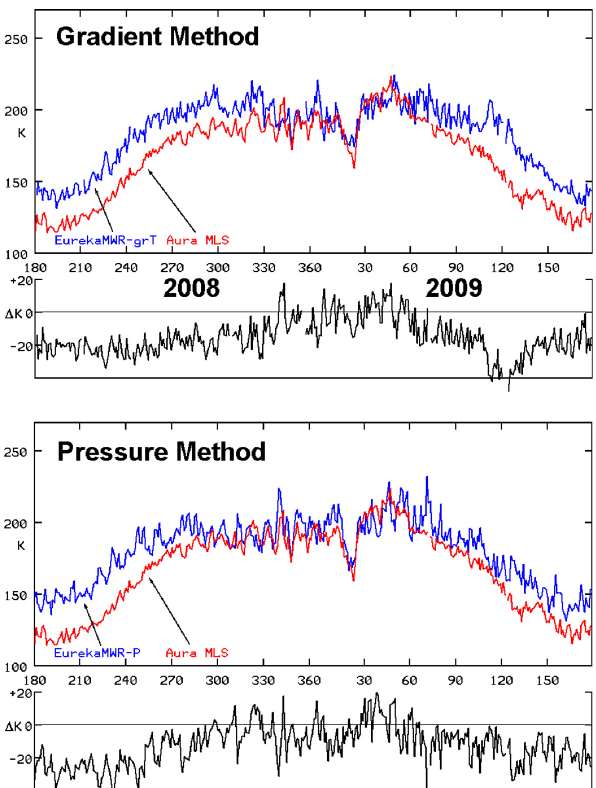
Fig. 7. Comparison between 90km temperatures calculated by the gradient method (upper panel, empirical model) and pressure method (lower panel, Aura MLS) for winter-centred 2008/2009. Be- low each comparison is a plot of the temperature differences: MLS minus Eureka MR.